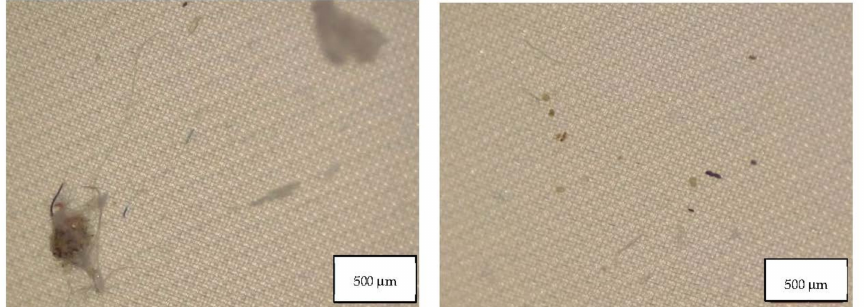
Figure 9. Microplastics detected in the filter of FFP2 B seen at the stereomicroscope with scale bar of 500 µ